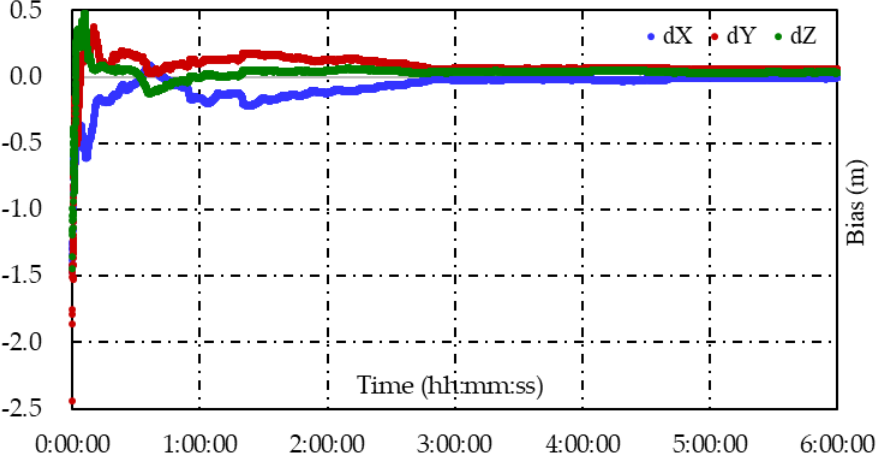
Figure 20. Coordinate biases from static PPP without MSJP correction.